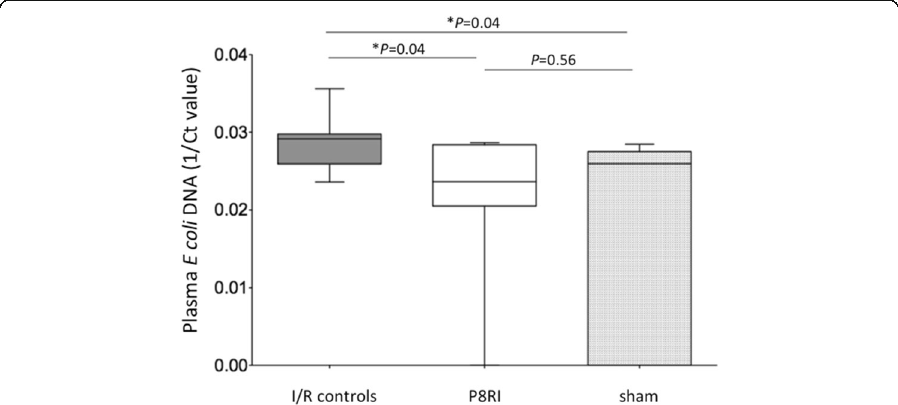
Fig. 3 Effect of P8RI on mesenteric ischemia/reperfusion-induced bacterial translocation. Bacterial translocation was assessed by the quantification of plasma DNA from Escherichia coli using real time PCR. Ct value represents the minimum number of cycles to detect plasma Escherichia coli DNA and is inversely correlated to the quantity of plasma DNA from Escherichia coli . P8RI administration limited the plasma concentration of DNA from E . coli compared to saline injection (* P